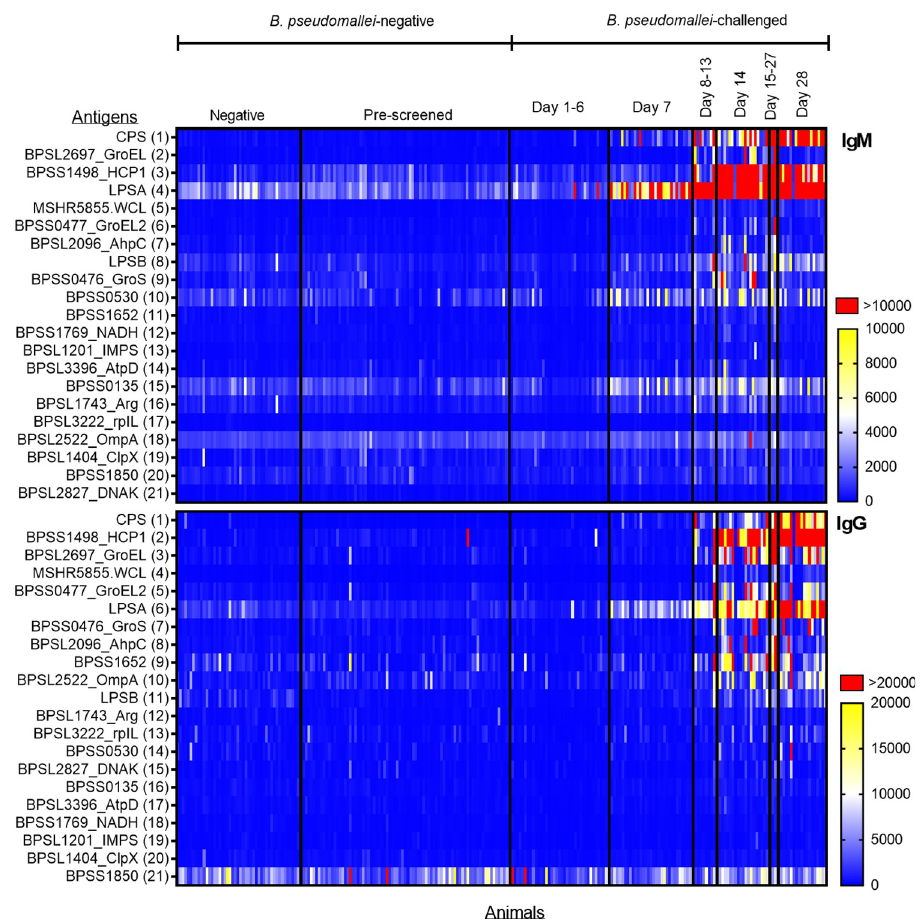
Fig 2. Antigen reactivity for B . pseudomallei -challenged and B . pseudomallei -negative NHP sera. Heat maps are shown displaying antigen reactivity for IgM (top panel) and IgG (bottom panel). Burkholderia antigens are shown in rows and columns represent individual serum samples. Samples included negative sera (n = 126 sample, n = 126 animals), B . pseudomallei aerosol challenged sera (n = 115 samples, n = 68 animals) and serum samples were further stratified by prescreening or time after B . pseudomallei challenge. Antigens were arranged in order by signal to noise ratio and were ordered differently for each isotype. Sera were run in duplicate and the average median fluorescence intensity values (MFI) are shown. IgM ranges were: 0 (blue), 5,000 (white), 10,000 (yellow), and > 10,000 (red) as indicated. IgG ranges were: 0 (blue), 10,000 (white), 20,000 (yellow), and > 20,000 (red) as